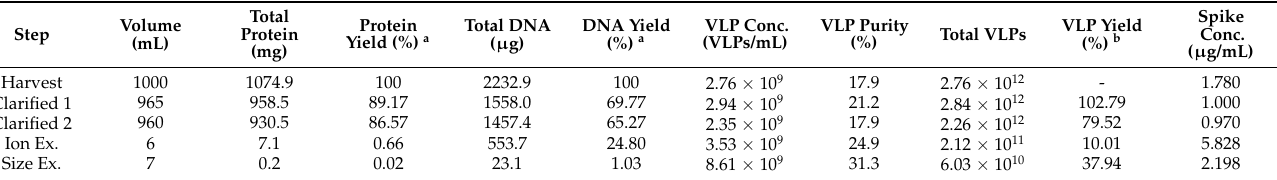
Table 2. Data of the different purification